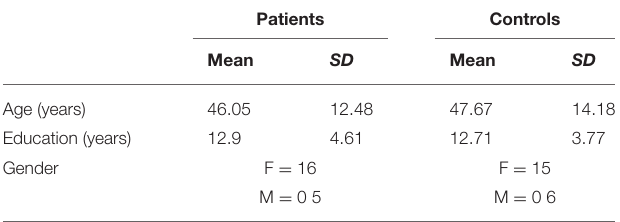
TABLE 1 | demographics.